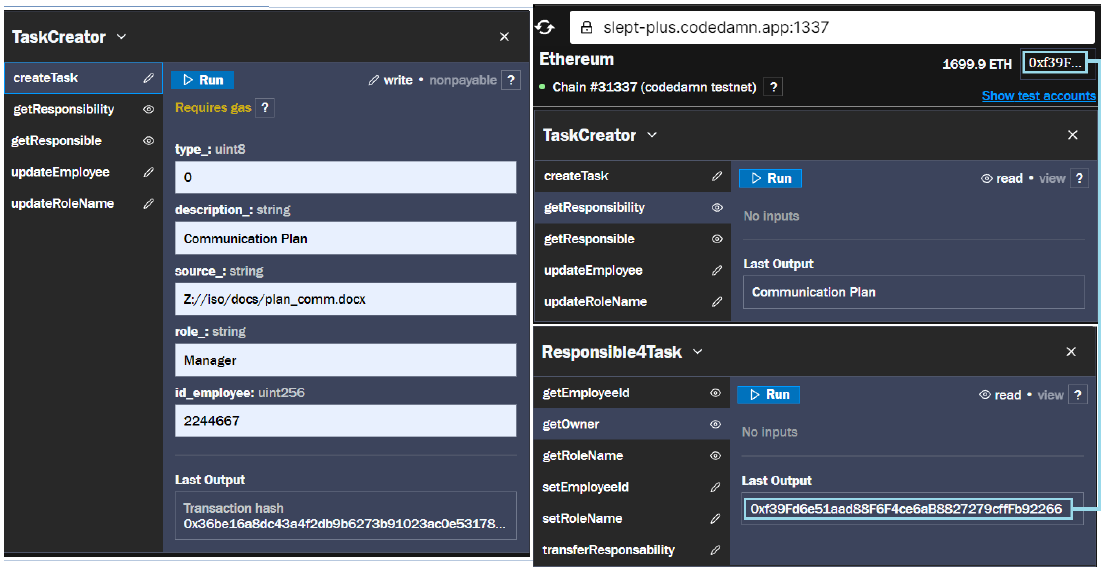
Figure 5: Test of a task creation - Manager must create the communication plan